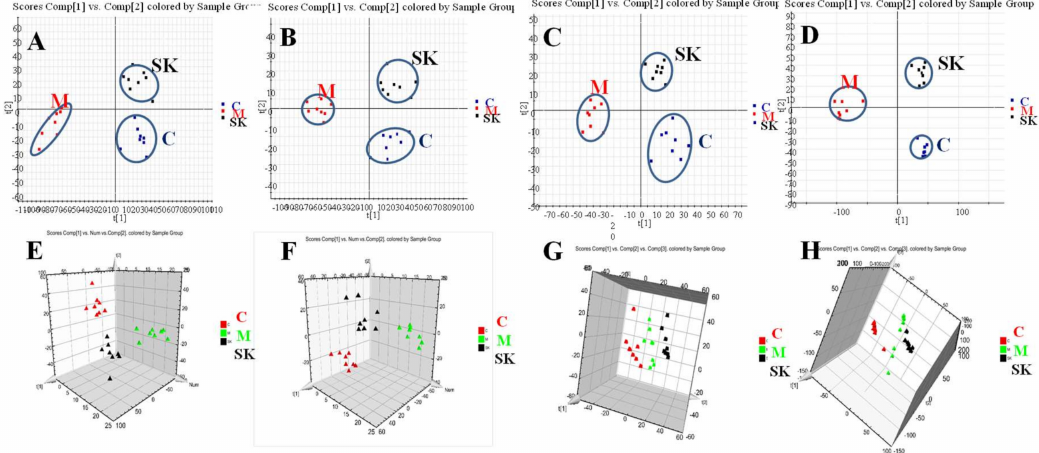
Figure 5. The PLS-DA score plot ( A , B , C , D ) and 3-D PLS-DA score plot ( E , F , G , H ) of urine samples ( A , B , E , F ) and plasma samples ( C , D , G , H ) from sham-operated, model and SK groups both in positive ( A , E , C , G ) and negative modes ( B , F , D , H